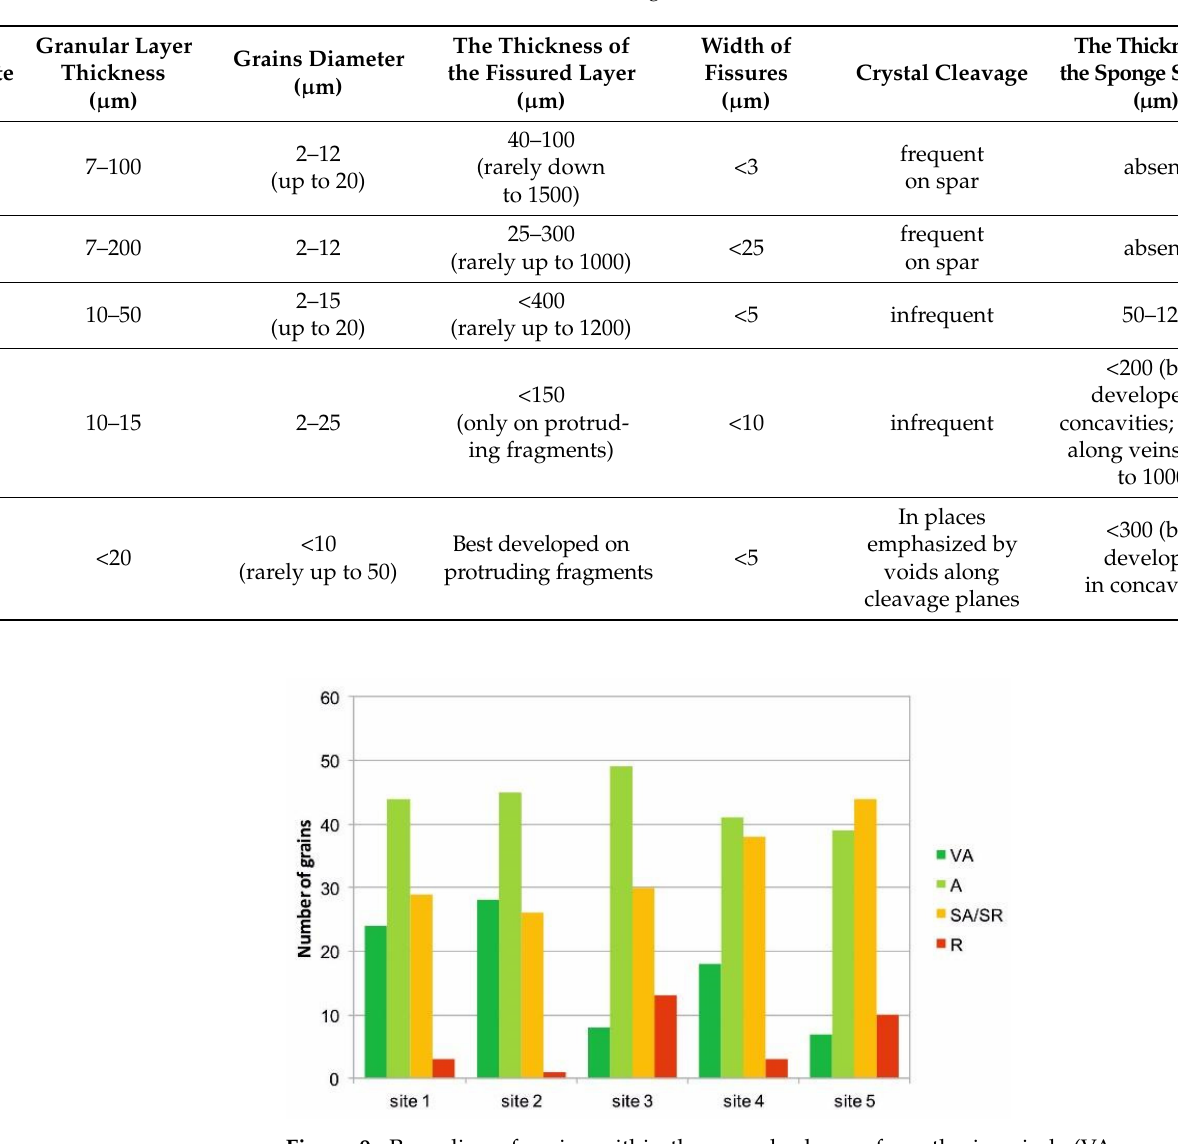
Table 2. Characteristics of weathering rinds (sites 1–5).